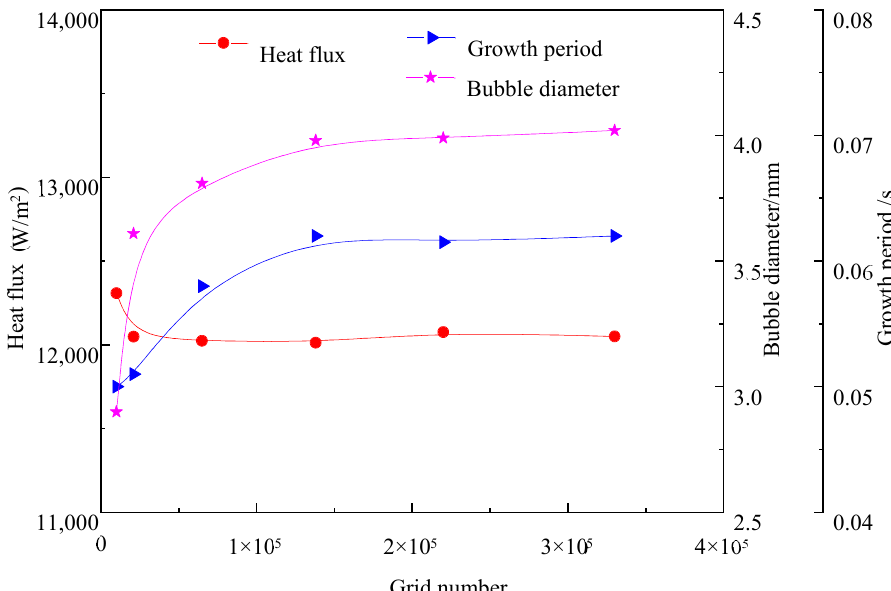
Figure 4. The results with different grid numbers.